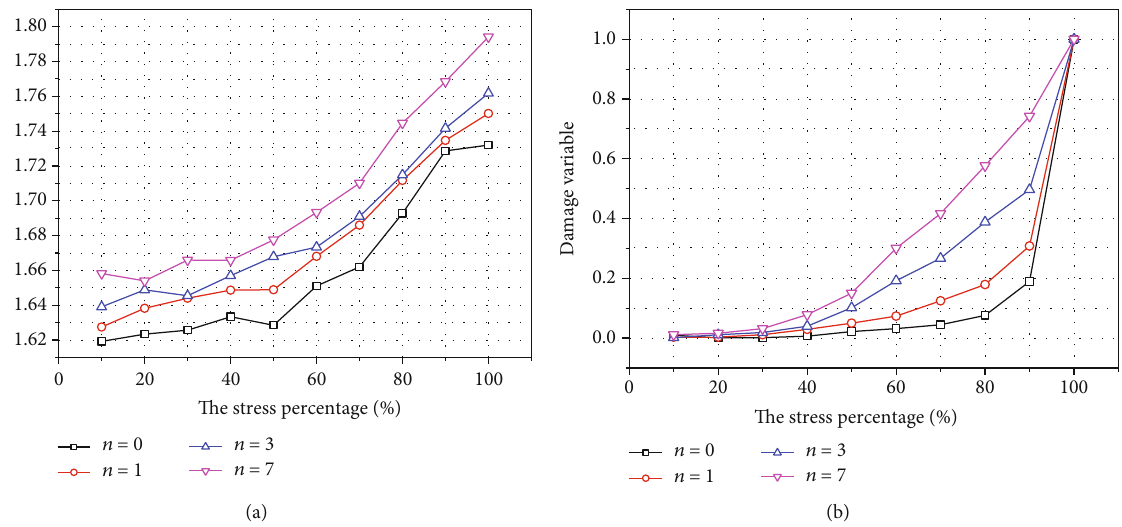
Figure 12: Curve of fractal dimension and damage variable to peak stress ratio. (a) Fractal dimension. (b) Damage